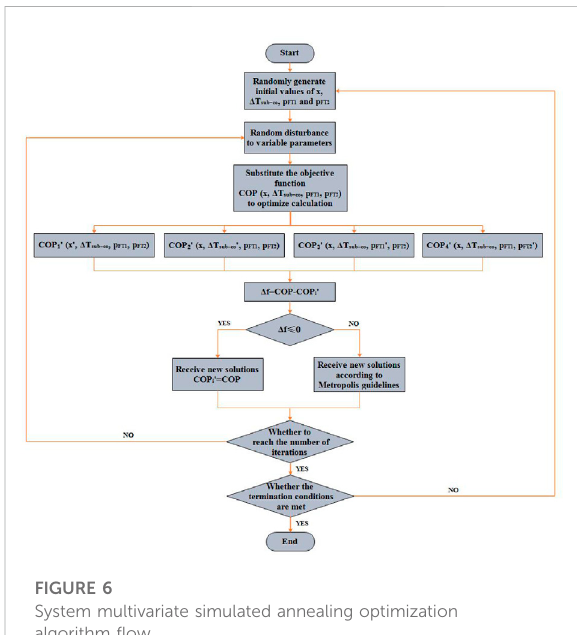
FIGURE 6 System multivariate simulated annealing optimization algorithm fl ow.